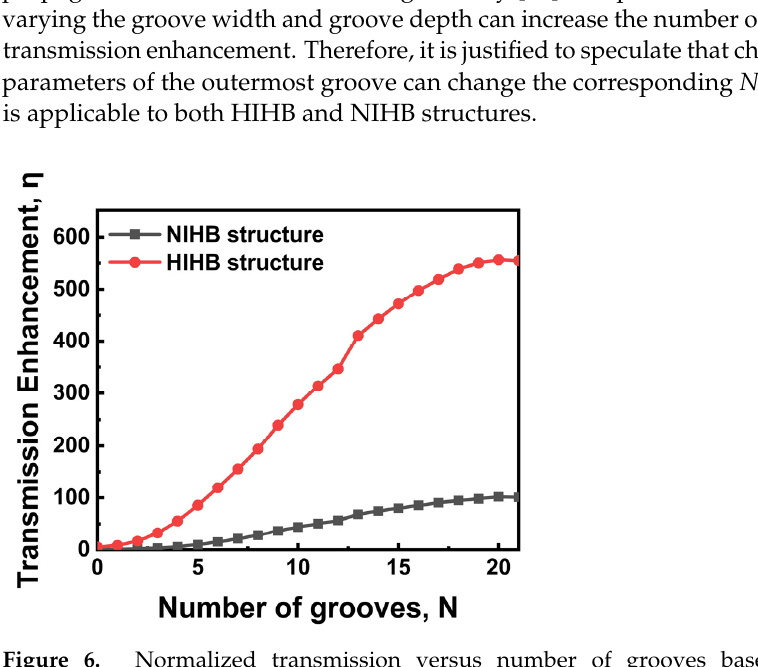
Figure 6. Normalized transmission versus number of grooves based on the optimized geometrical parameters.